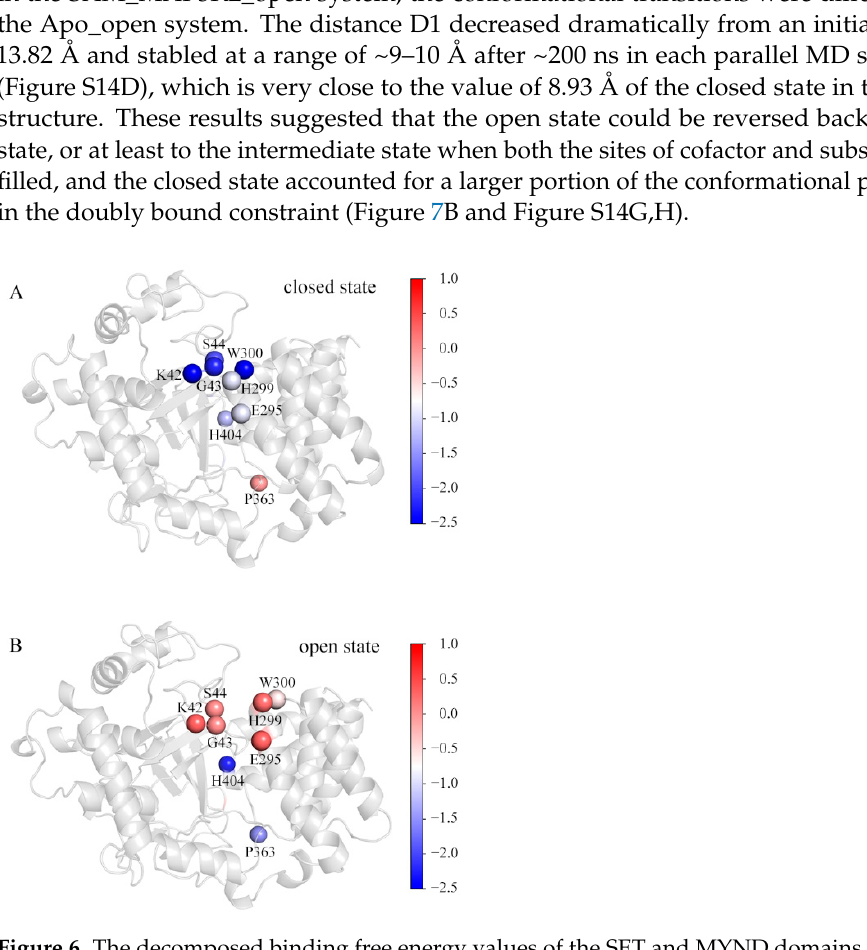
Figure 6. The decomposed binding free energy values of the SET and MYND domains toward the CTD. The representative structures in the ( A ) SAM_MAP3K2 and ( B ) Apo systems are colored by the decomposed binding free energy levels of the key residues. The color scale is shown on the right changing from red (high decomposed binding free energy) to blue (low decomposed binding free energy).